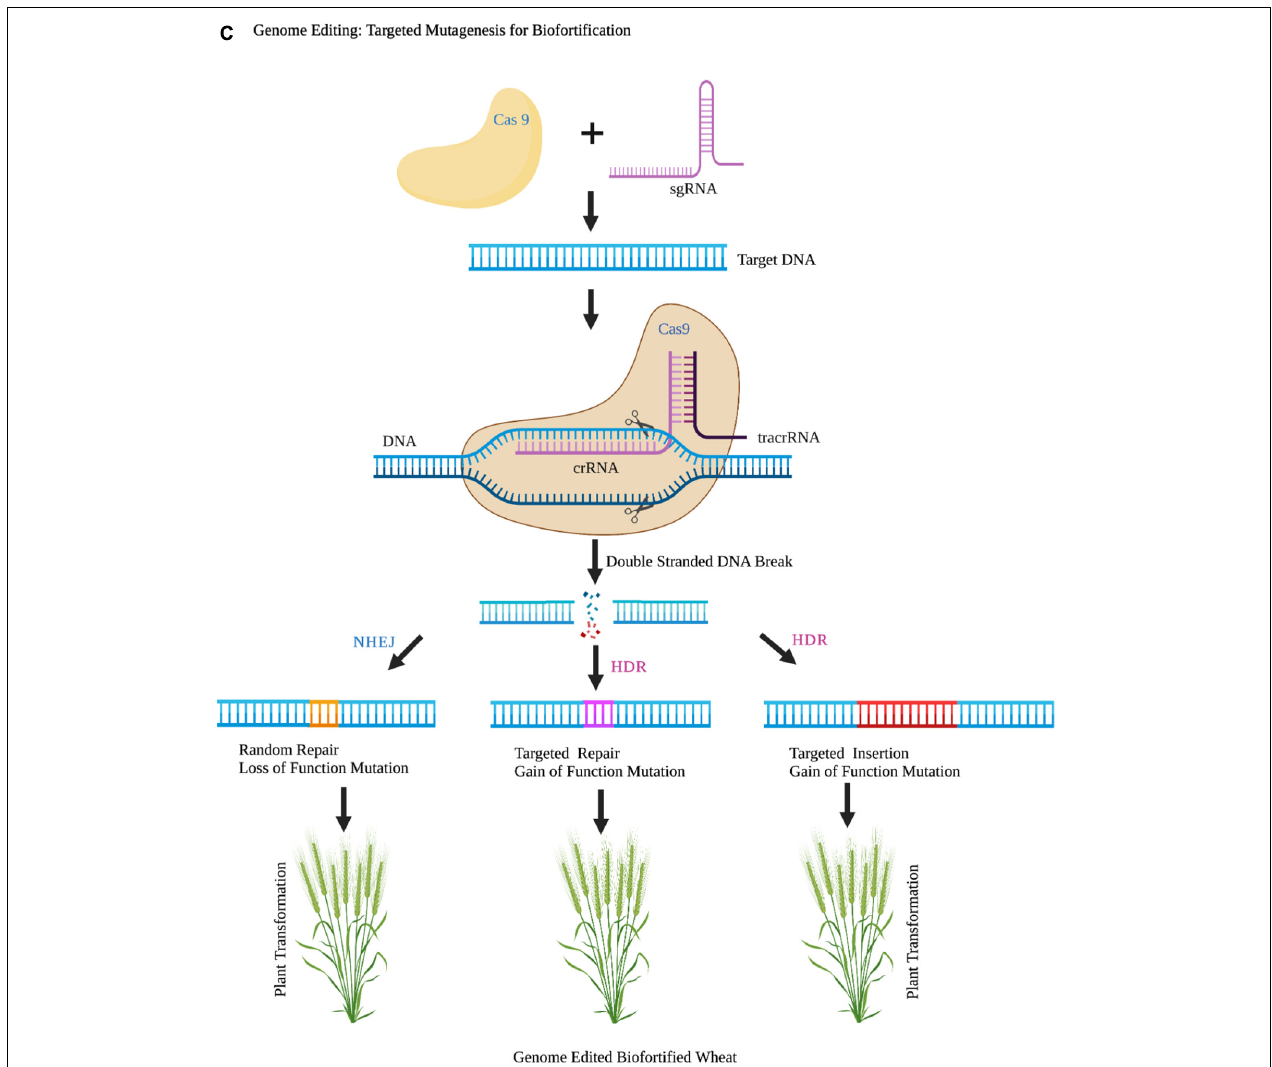
FIGURE 2 | Schematic representation of conventional (A) genetic engineering (B) and genome editing (C) approaches in wheat for targeted biofortifcation of micronutrients. Genetic engineering and genome editing approaches in combination with conventional breeding offers simultaneous incorporation of multi-nutrient (minerals and vitamins) traits along with improved physiological and agronomic